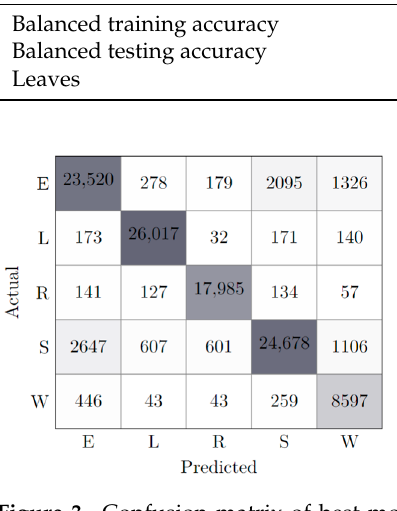
Table 3. Performance of best model (AllFeatures).